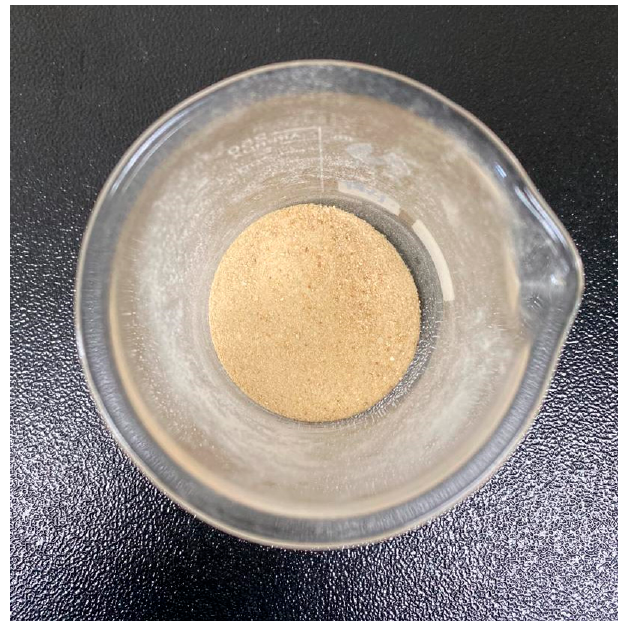
Figure 1. Freeze-dried Bacillus subtilis.